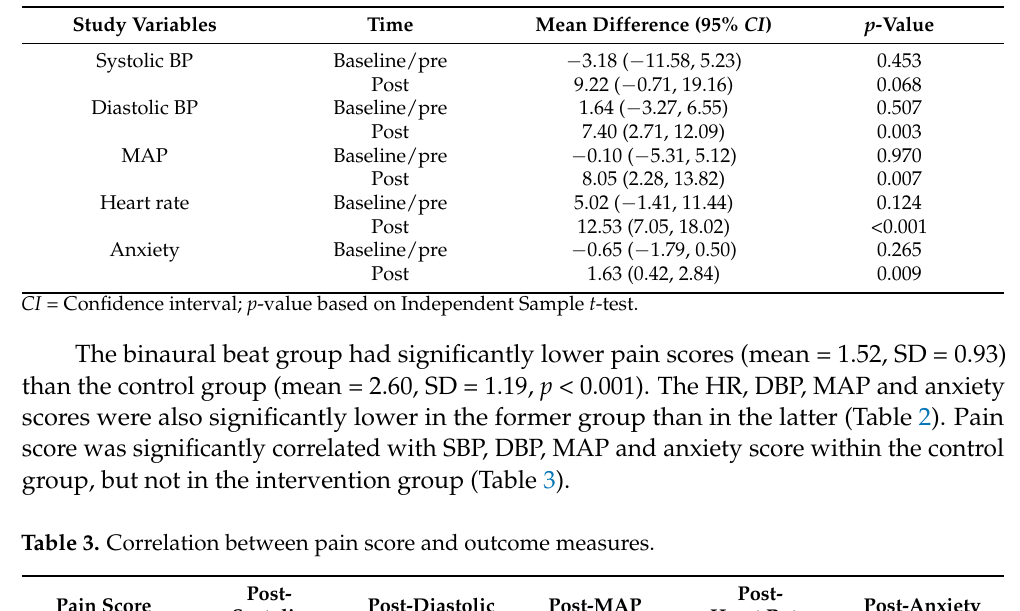
Table 3. Correlation between pain score and outcome measures. Pain Score